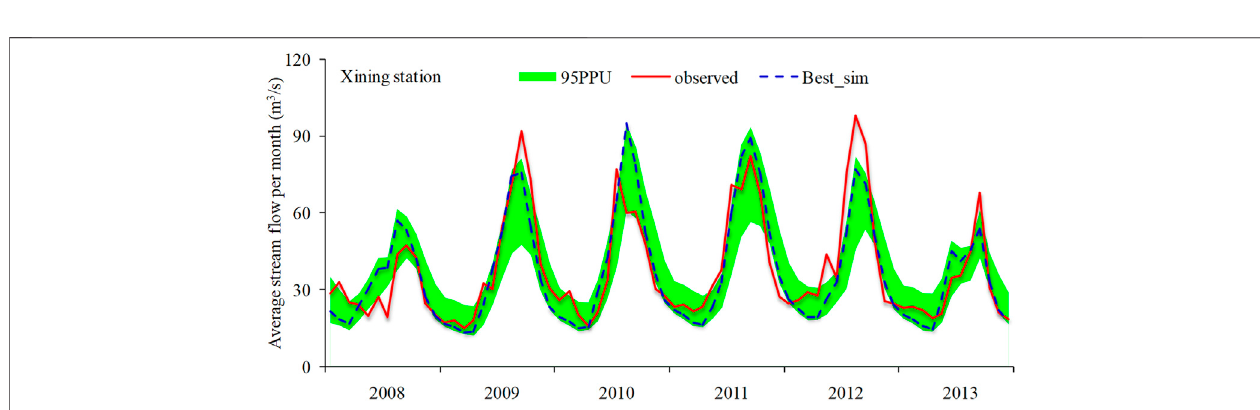
Frontiers in Earth Science |